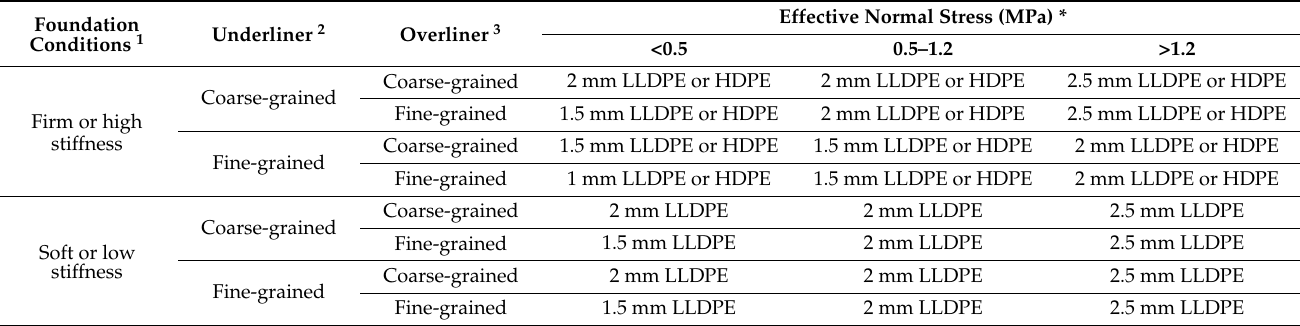
Table 3. General guide to selecting an appropriate linear low-density (LLDPE) or high-density (HDPE) polyethylene geomembrane, modified from [30,43]. Other types of geomembranes described by Fourie et al. [30] that could also be suitable are not